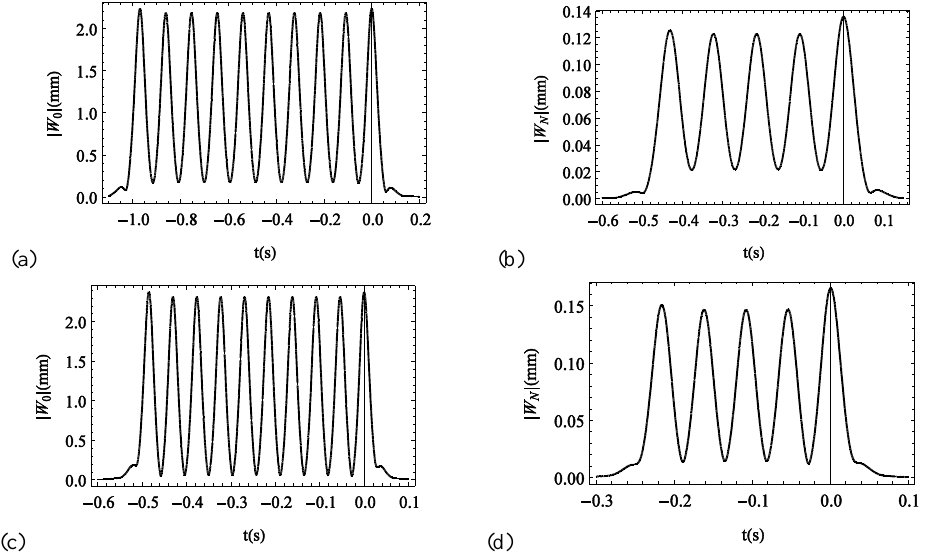
Fig. 8. The maximum displacement (